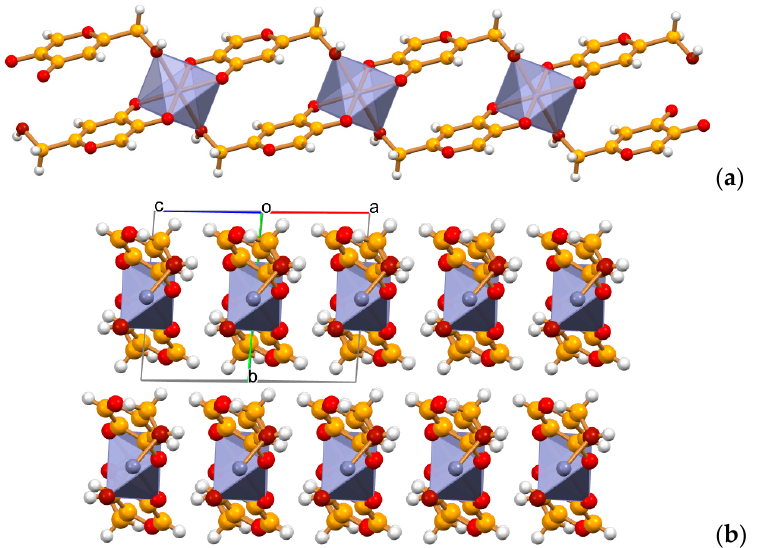
Figure 3. The 1D coordination polymer ( a ) extending along the (010) direction in crystalline Zn(KA) 2 ; note how the six-membered rings are π -stacked within the chain at a distance of ca. 3.2 Å. 1D chains are arranged parallel to each other in the crystal ( b ). Zinc(II) cations are blue-grey.